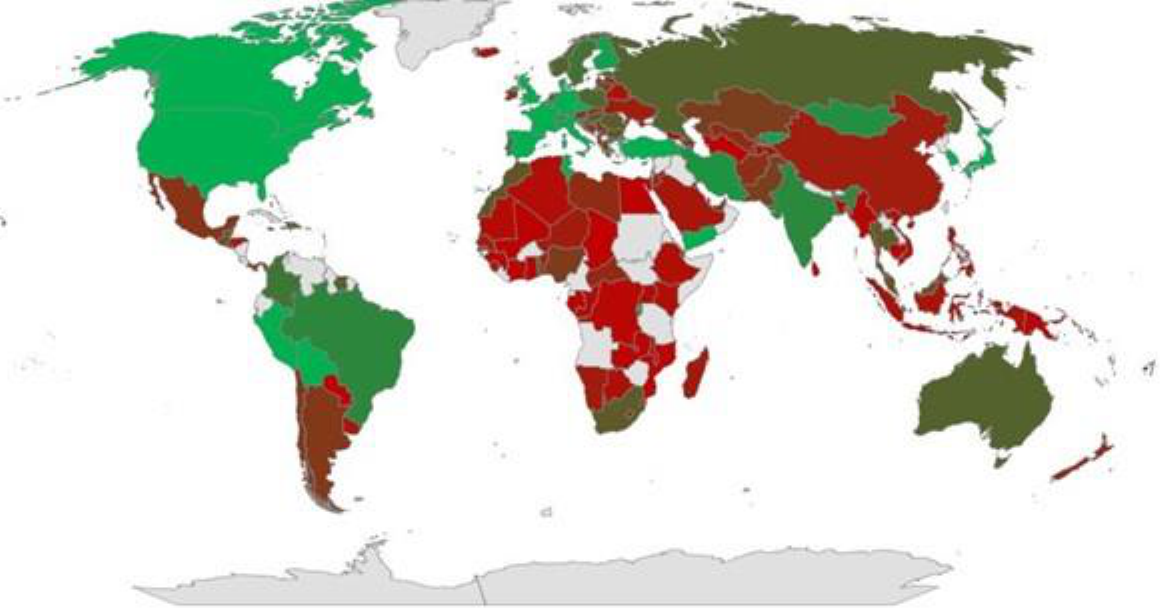
Figure 1. The ratio of COVID-19-related economic supports to GDP (%). Source: Authors ’ calcula- tions based on IMF Database of Fiscal Policy Responses To COVID-19. https://www.imf.org/en/Top- ics/imf-and-covid19/Fiscal-Policies-Database-in-Response-to-COVID-19 (accessed on 1 October 2022).